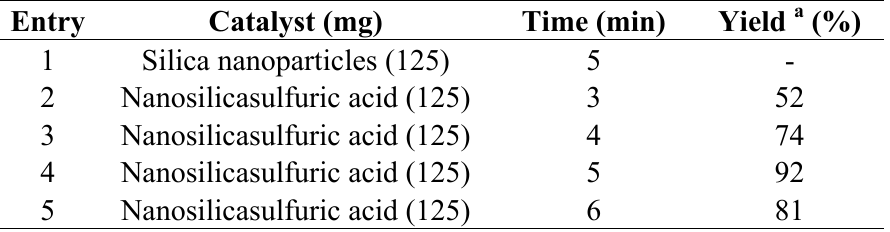
Table 2. Optimization of reactions under microwave irradiation (400 W).